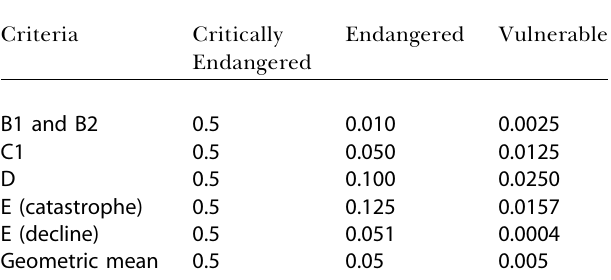
Table 3. Weights for Red List Categories Critically Endangered, Endangered, and Vulnerable, Based on Relative Extinction Risk Associated with Various Red List